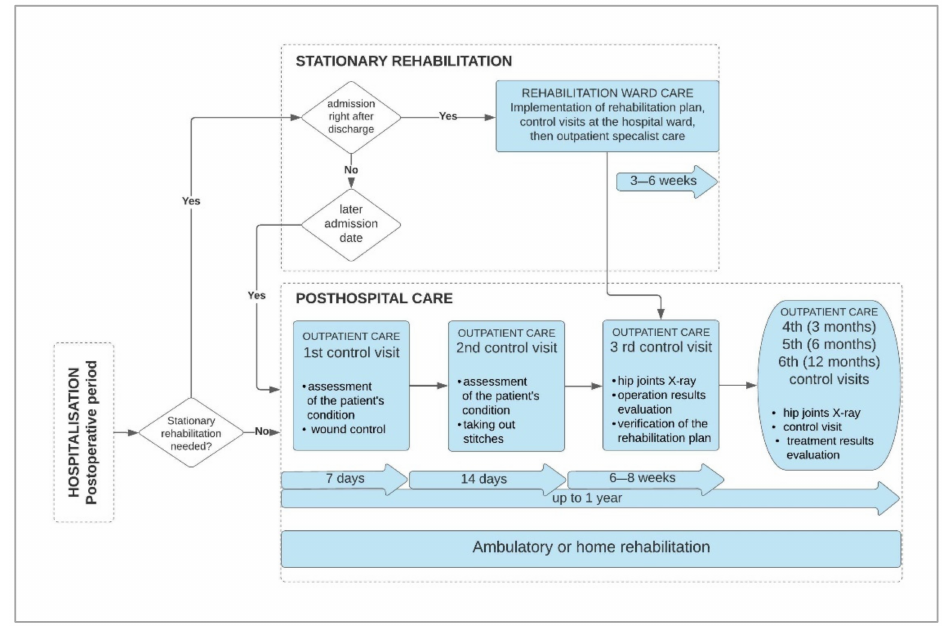
Figure 4. General diagram of the current posthospital patient care process after total hip arthroplasty. Source: own